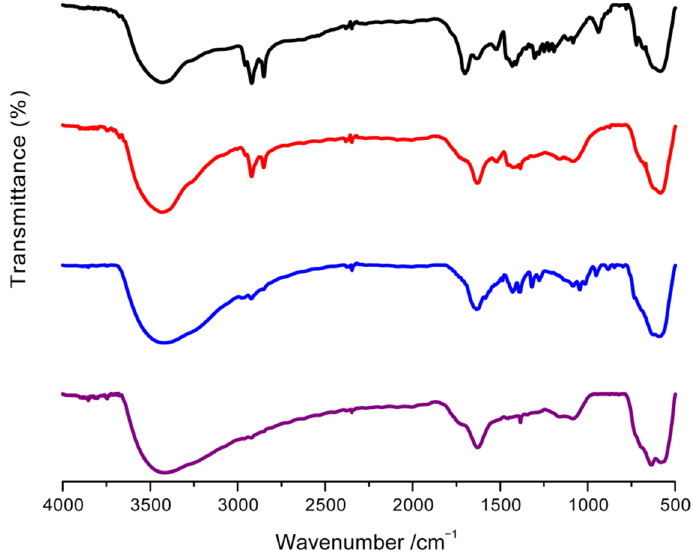
Figure 4. FTIR spectra of bare Fe 3 O 4 particles (magenta) and of functionalized Fe 3 O 4 particles with AA (blue), OA (red), and LA (black).